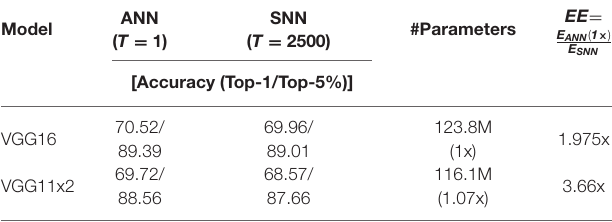
TABLE 4 | Accuracy, Total # parameters and Energy Efficiency EE for converted SNN topologies (refer Table 5 ) of latency T = 2,500 and corresponding ANN on imagenet data.